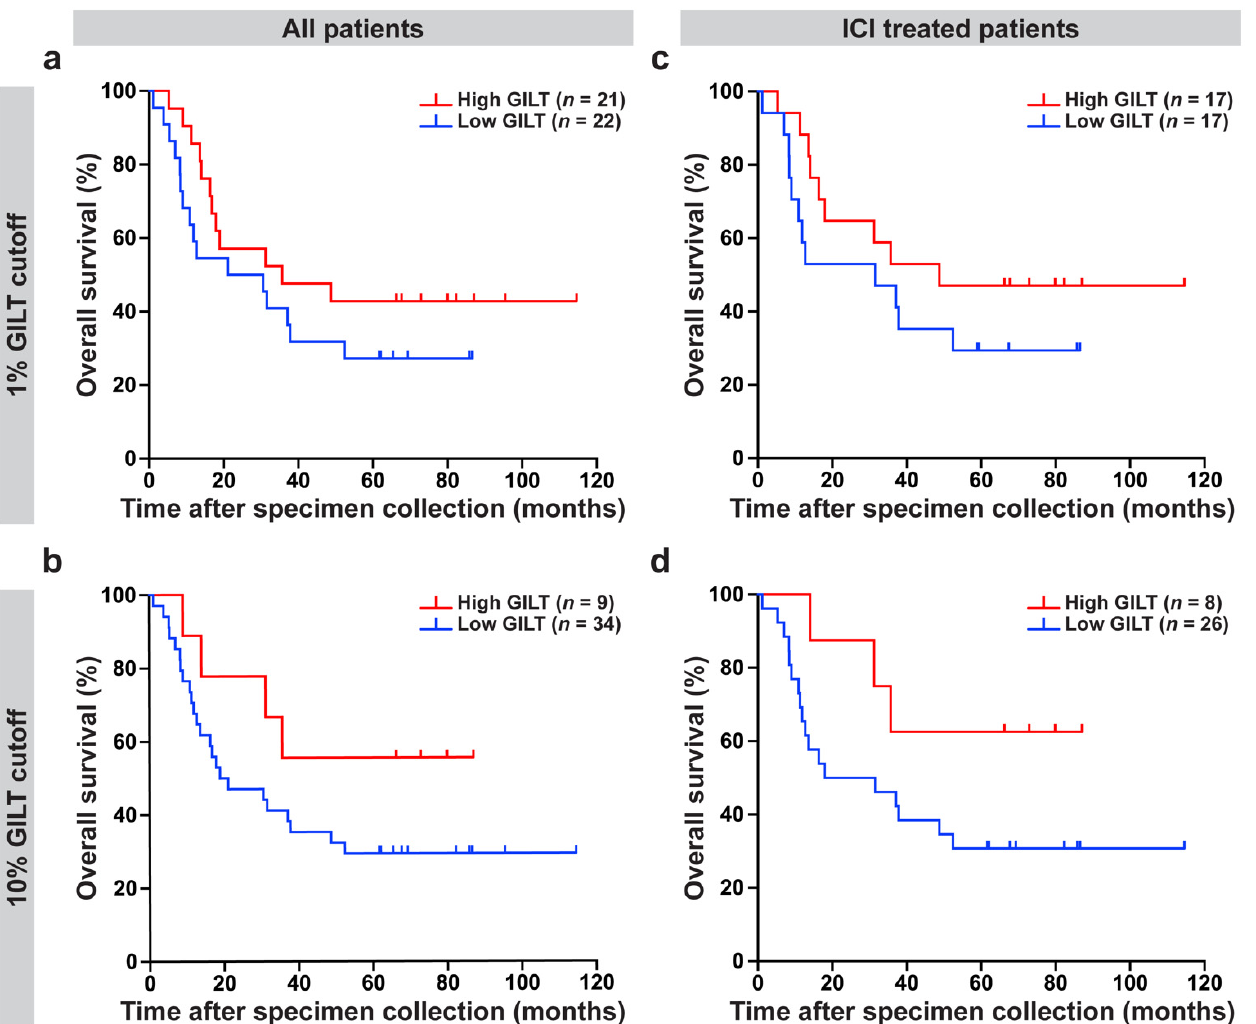
Figure 3. High GILT protein expression in melanoma cells is associated with improved overall survival in metastatic melanoma patients treated with immune checkpoint inhibitors (ICI). For the overall survival analyses, GILT protein expression in melanoma cells was evaluated as a continuous variable. The relationship between overall survival and GILT protein expression in melanoma cells was assessed using the Cox proportional hazards model, with stage at the time of specimen collection, age, and sex included as adjustment factors. ( a , b ) High GILT protein expression in melanoma cells was associated with a longer overall survival in all of the patients in the clinical dataset ( p = 0.1270; HR [95% CI] = 0.7139 [0.4630, 1.1010]); however, it did not reach statistical significance. ( c , d ) In the subset of patients treated with ICI, high GILT protein expression in melanoma cells was associated with a significantly improved overall survival ( p = 0.0347; HR [95% CI] = 0.5682 [0.3363, 0.9601]). Kaplan–Meier plots to visualize data using a cutoff of ( a , c ) 1% and ( b , d ) 10% of melanoma cells with GILT staining. HR, hazard ratio; CI, confidence